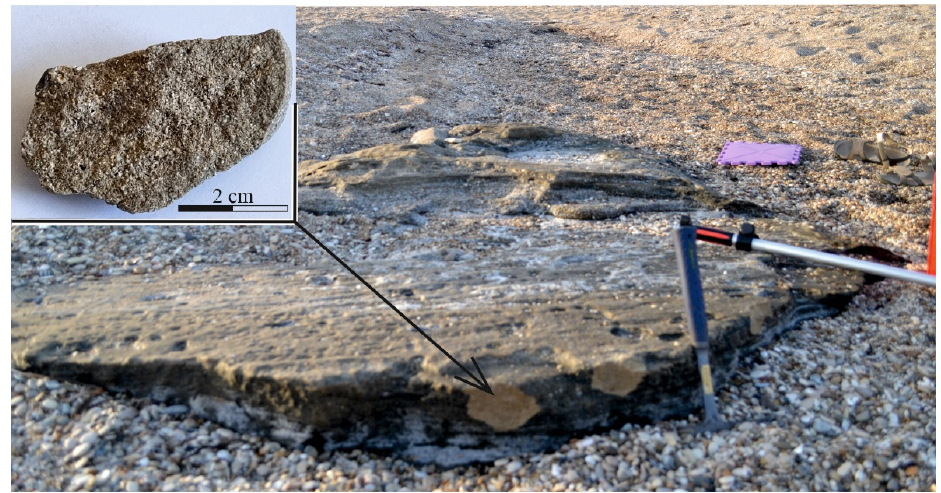
Figure 3. The southern study area in Kanalia. Figure presents a well cemented beachrock outcrop. In the inset photo, a detailed view of the sample is presented.